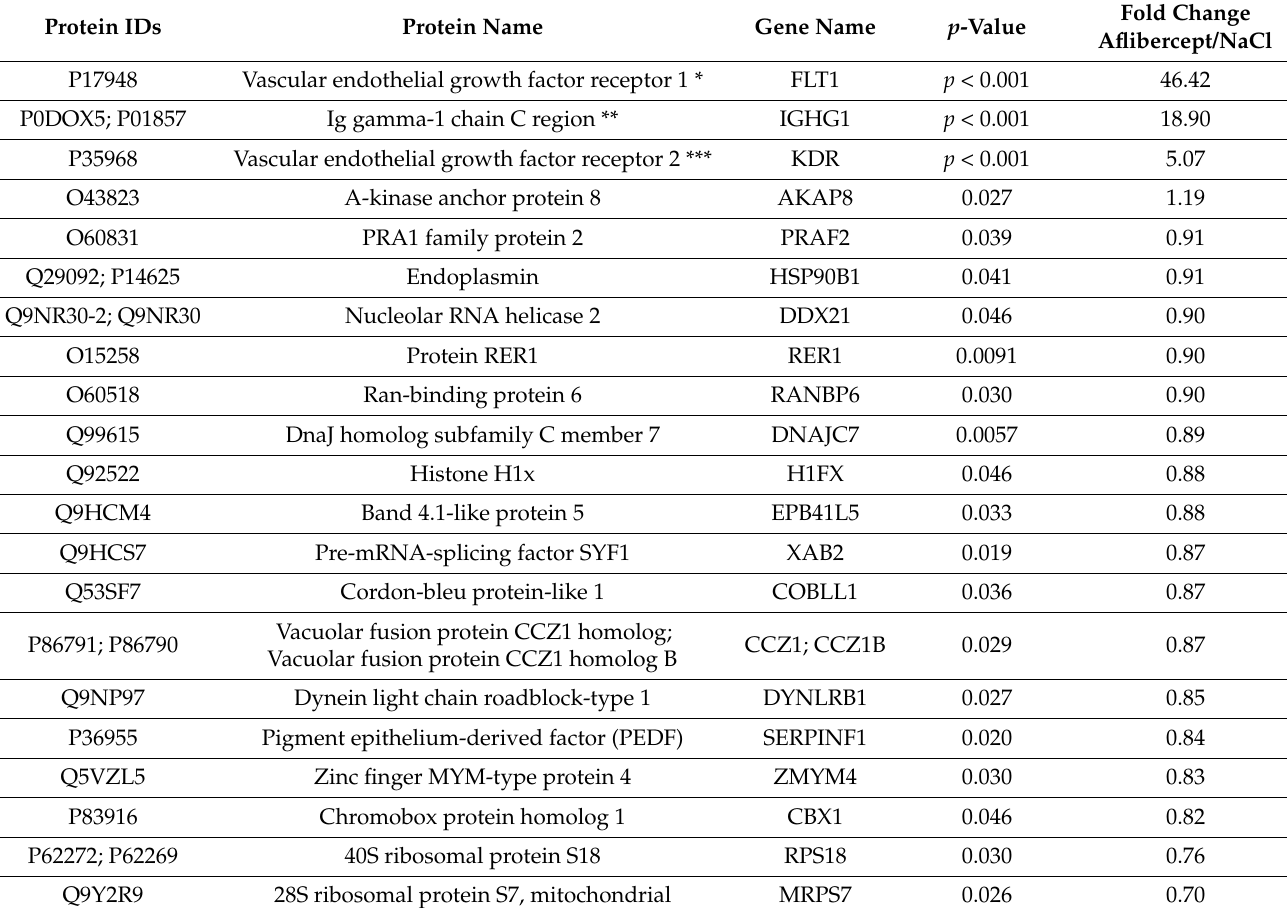
Table 1. Proteins that significantly changed in content following aflibercept